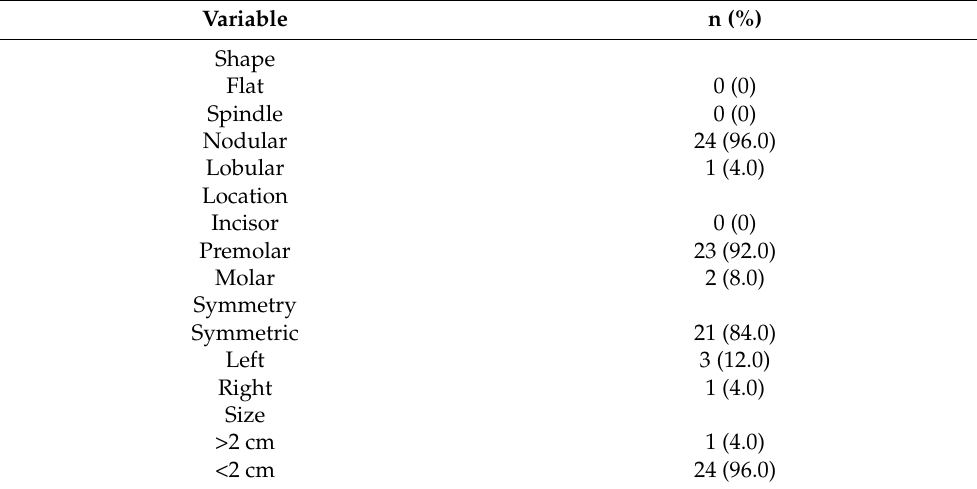
Table 4. Clinical oral examinations of torus mandibularis in hemodialysis patients (n = 25).